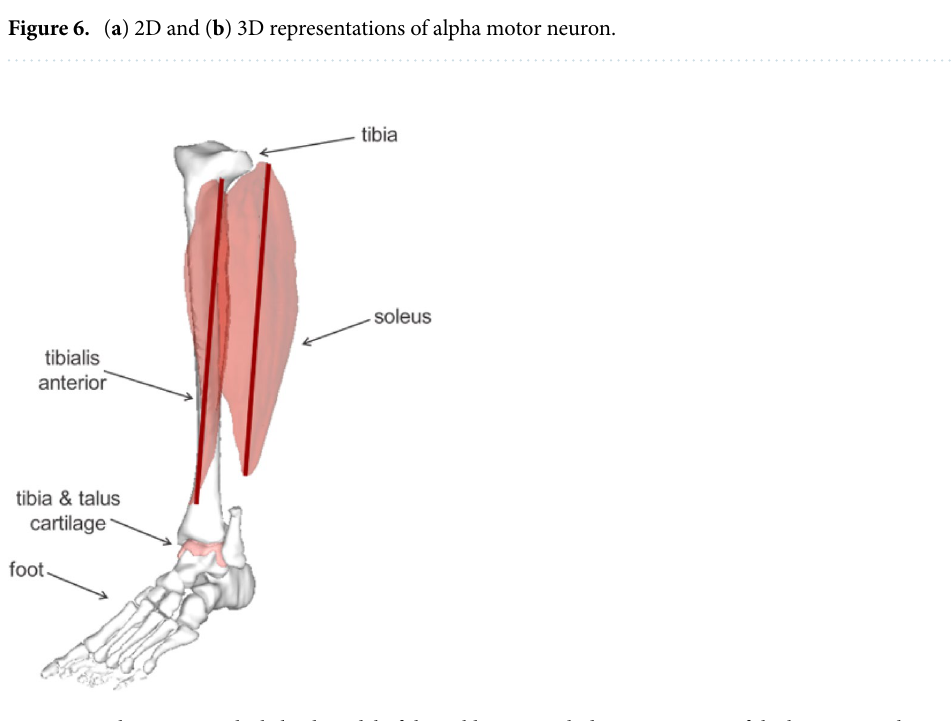
Figure 7. Abaqus musculoskeletal model of the ankle joint including geometries of the bones, muscles, and